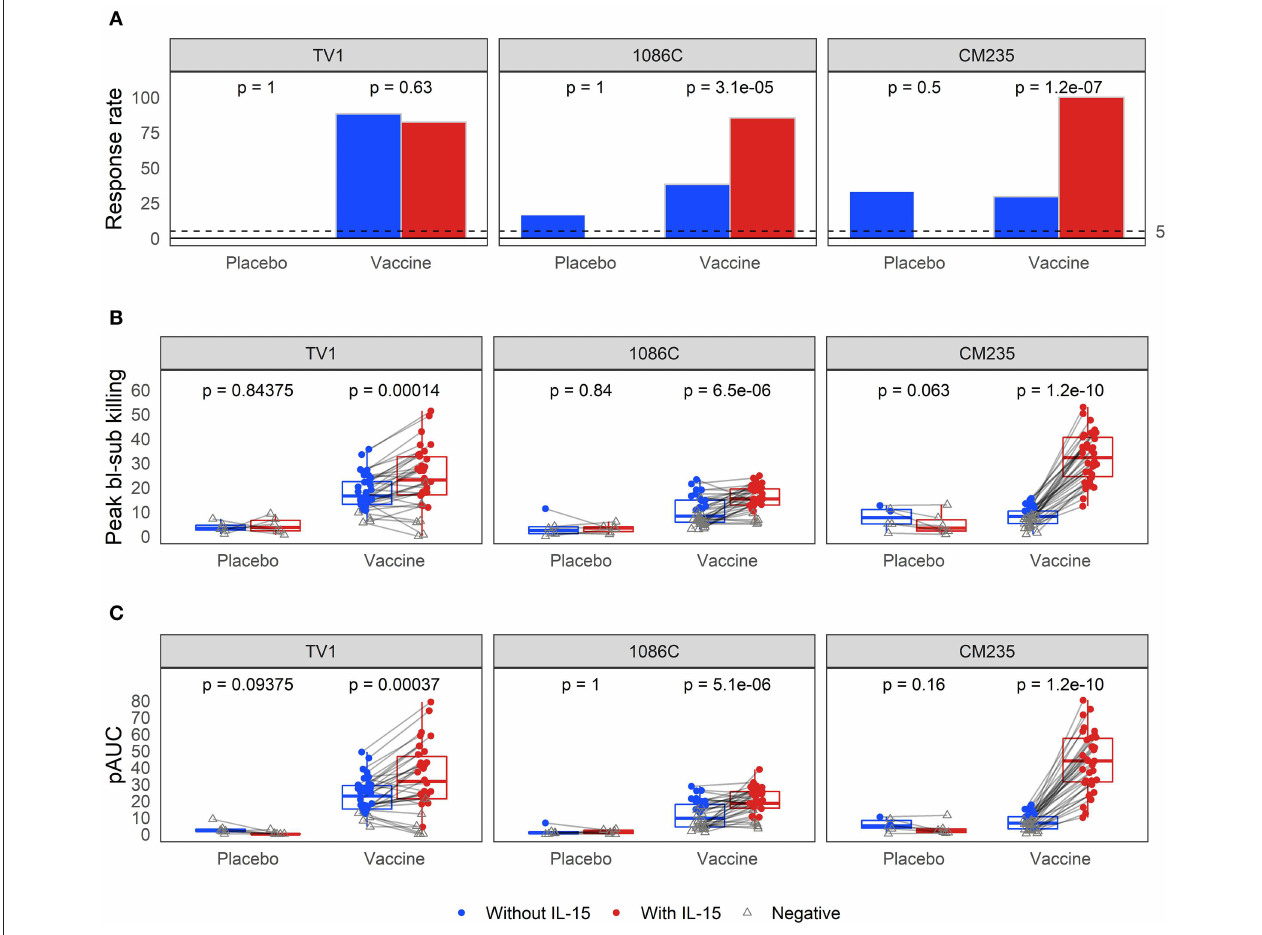
FIGURE 7 | Comparison of (A) response rates, (B) peak % killing, and (C) pAUCS as determined from the baseline-subtracted ADCC response curves, performed with the three different IMCs in the presence and absence of IL-15. Responses from the same sample are connected with gray lines. McNemar p -values are reported for differences in response rates; paired Wilcoxon p -values are reported for both peak % killing and pAUC. All p -values are unadjusted. TV1 and 1086C are both vaccine-matched, while CM235 is not.